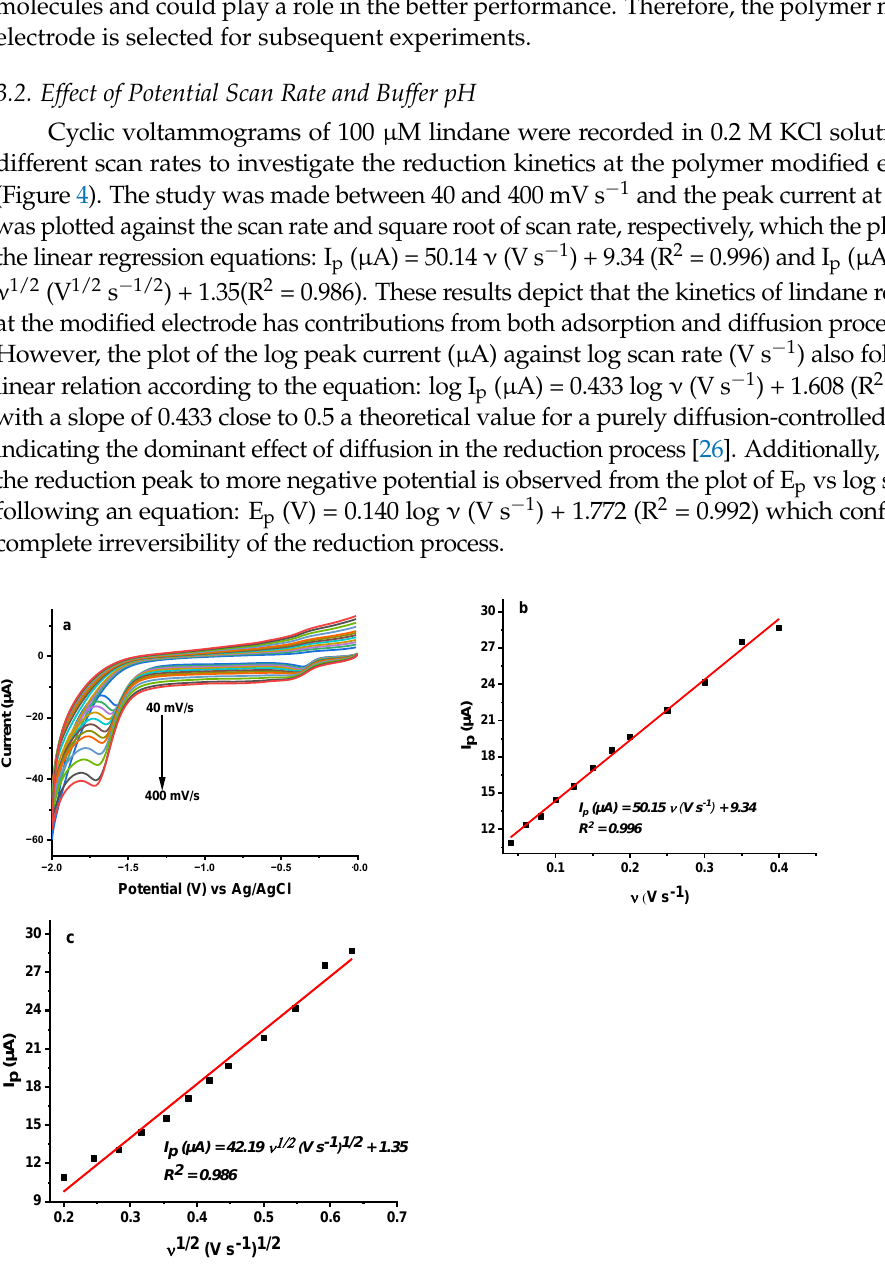
Figure 3. Square wave voltammogram in the absence (broken) and presence (solid) of lindane in nitrogen saturated 0.2 M KCl solution at glassy carbon electrode. SWV conditions: E step = 0.01 V; Amplitude = 0.1 V; Frequency = 15.0 Hz.